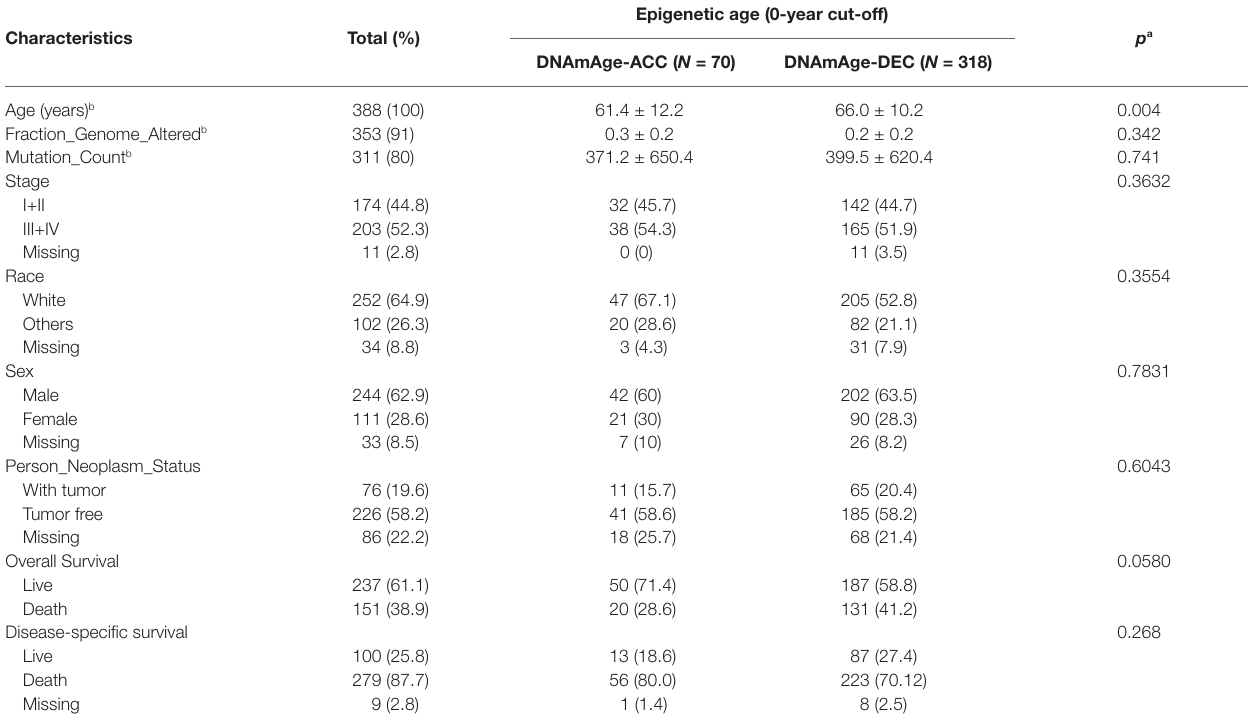
TABLE 1 | Demographic and clinicopathological characteristic between DNA methylation (DNAm) age accelerated group (ACC) and DNAm age decelerated group (DEC).